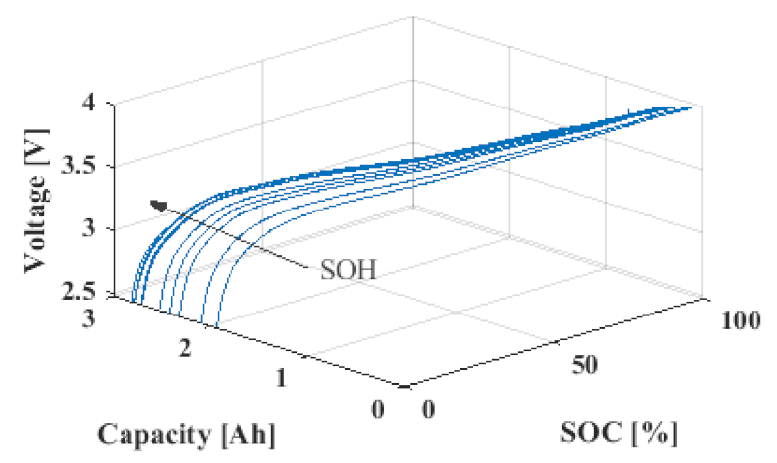
Figure 6. Characterization of the SOH based on the cell voltage and SOC, and capacity at ambient temperature.